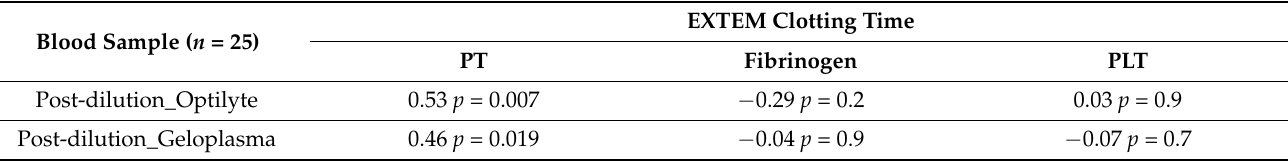
Table 1. Correlations between EXTEM and INTEM clotting times and standard laboratory tests 1